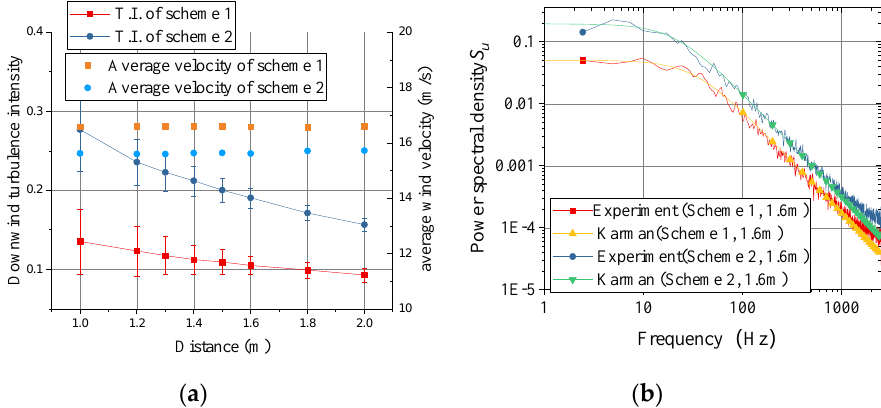
Figure 8. Description of the flow field behind the grilles. ( a ) Turbulence intensity and average velocity (Re: 0.8 × 10 6 ); ( b ) Comparison of the PSD (1.6 m behind the grille).